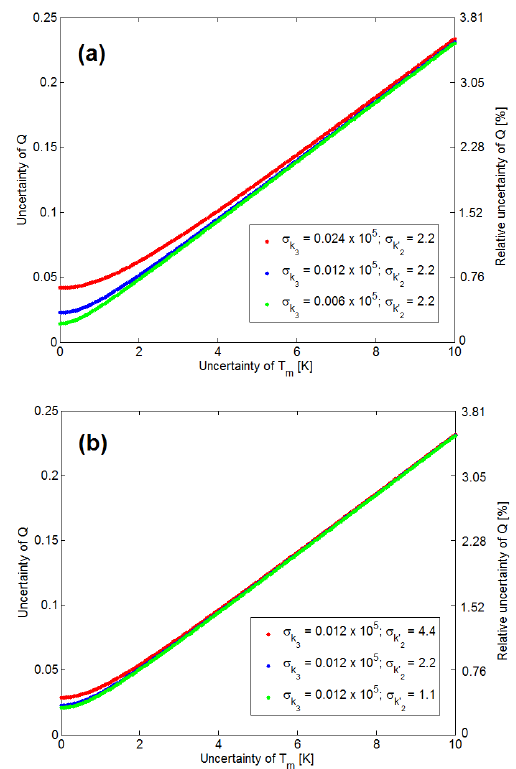
Figure 8. The uncertainty of the conversion factor Q as a function of the uncertainty in the mean temperature ( T m ) and for three groups of the uncertainties in the constants k 3 and k (cid:48) (blue line), double of the nominal value (red line), and half of the nominal value (green line) for (a) a fixed uncertainty of k (cid:48) fixed uncertainty of k 3